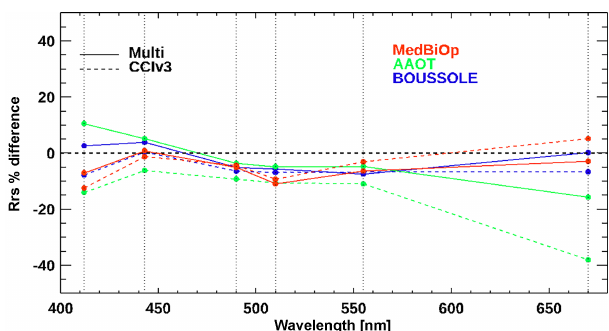
Figure 9. Relative difference between the Multi product and CCIv3 satellite observations and in situ measurements (MedBiOp in red, AAOT in green, and BOUSSOLE in blue). The number of matchups used from each dataset is summarized in Table 3. Target wave- lengths are marked with vertical dotted lines. As a reference the two red lines correspond to the black and blue lines in Fig. 7 for the Multi product and CCIv3,